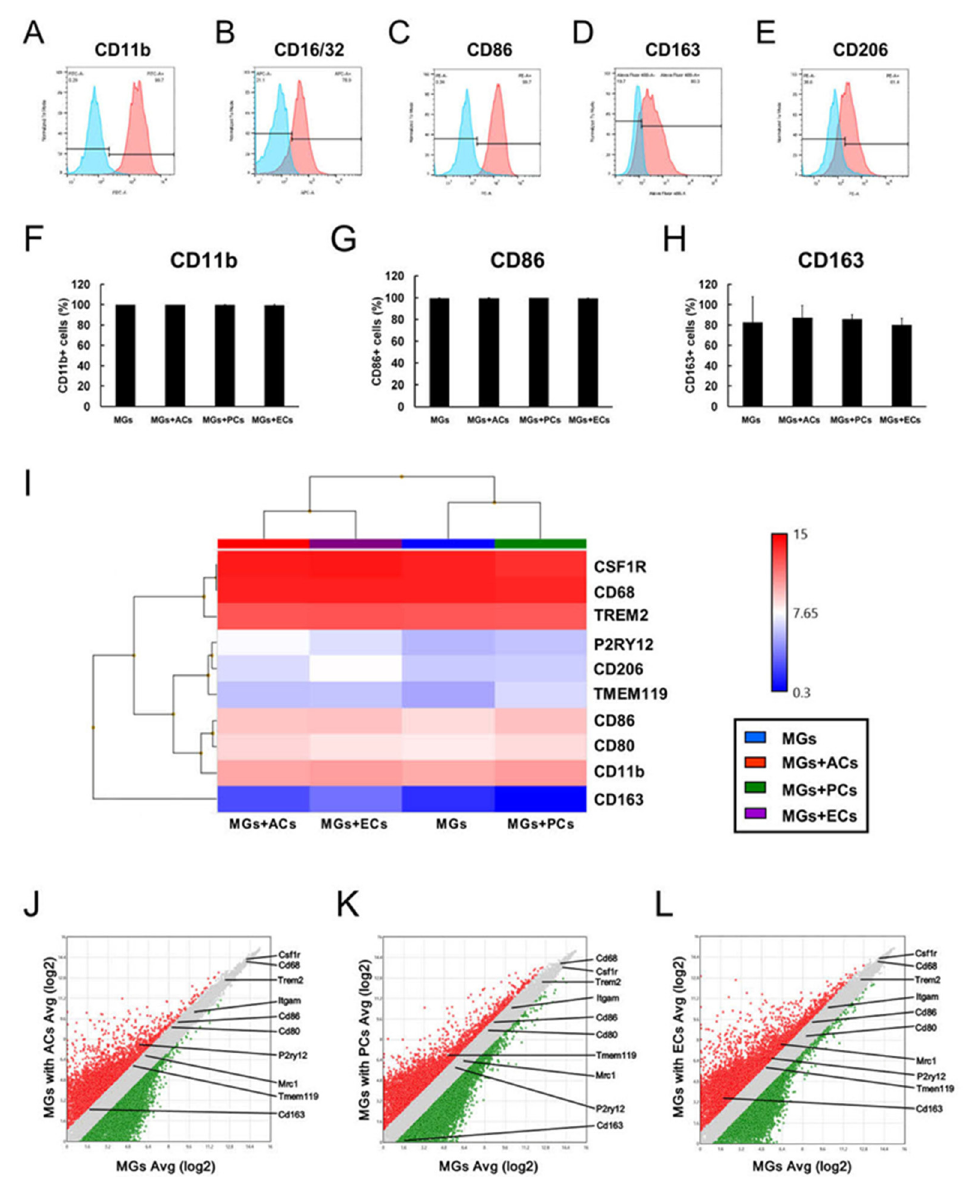
Figure 6. MG markers investigated by FACS analysis ( A – H ). MGs expressed various markers: CD11b ( A ), CD16/32 ( B ), CD86 ( C ), CD163 ( D ), and CD206 ( E ). FACS analysis also showed that the presence of ACs, PCs, or ECs did not affect the CD11b+ ( F ), CD86+ ( G ), and CD163+ cell populations ( H ) compared with those in cultures of MGs alone ( F – H ). Heat mapping analysis of MG-related gene expression patterns ( I ). Scatter plot analysis of MG-related genes between MGs cultured alone and MGs coincubated with ACs ( J ), PCs ( K ), or ECs ( L ). Statistical analysis was performed using one-way ANOVA, followed by Bonferroni post-hoc tests (( F – H ); n = 3 for each group). Abbreviations: AC, astrocyte; EC, endothelial cell; MG, microglial cell; PC, pericyte. Then, the M1/M2 expression patterns of MGs were investigated after being cultured Supplementary Tables S7–S9 summarize the fold change values of the aforementioned with ACs, PCs, or ECs under conditions that enable direct cell–cell contacts, incubating genes between MGs cultured with ACs, PCs, and ECs, respectively, and alone (MGs with ACs, PCS, and ECs/MGs alone, respectively). Scatter plot analysis shows the mCherry + MGs alone with the same number of ACs, PCs, or ECs for three days. mCher- ry + MGs were analyzed by FACS, which revealed no significant difference in CD11b + (Figure 6F), CD86 + (Figure 6G), and CD163 + (Figure 6H) cell populations between the control and AC-, PC-, or EC-cocultured MGs. Heat mapping analysis was also per- formed, which also showed that the conventional (CD11b (ITGAM), CSF1R, TREM2, TMEM119, and P2RY12), M1 (CD68, CD80, and CD86), and M2 (CD163 and CD206